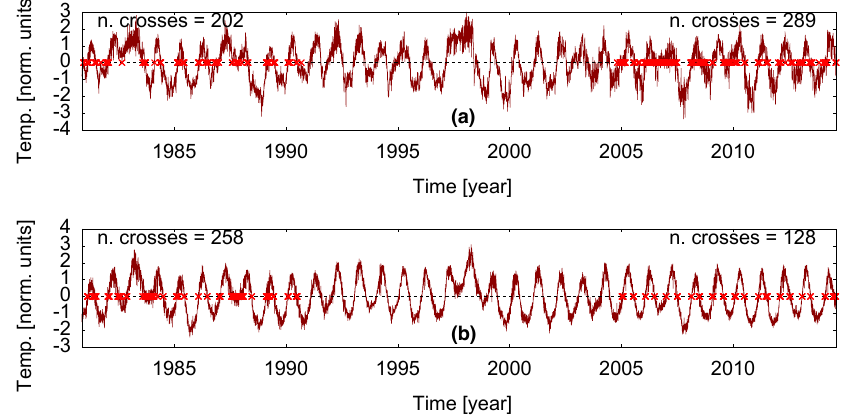
Figure 5.Normalised SAT time series and number of zero-crossings in the regions indicated with a circle in Fig. 4(c). In the red region (2.5 Figure 5. Normalised SAT time series and number of zero crossings in the regions indicated with a circle in Fig. 4c. In the red region (2.5 ◦ N, N, 245 E), panel (a), the number of zero-crossings increases in the last ten years with respect to the first ten years (289/202 respectively), 245 ◦ E) (a) , the number of zero crossings increases in the last 10 years with respect to the first 10 years (289 and 202, respectively), while in while in the blue region (7.5 S, 250 E), panel (b), it decreases (128/258 in the last/first ten years). the blue region (7.5 ◦ S, 250 ◦ E) (b) , it decreases (128 and 258 in the last and first 10 years).